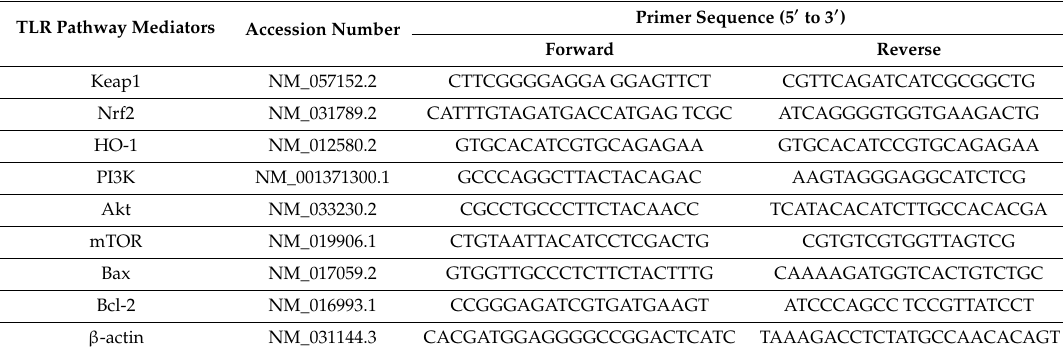
Table 1. Primers sequence used for real-time PCR for gene expression